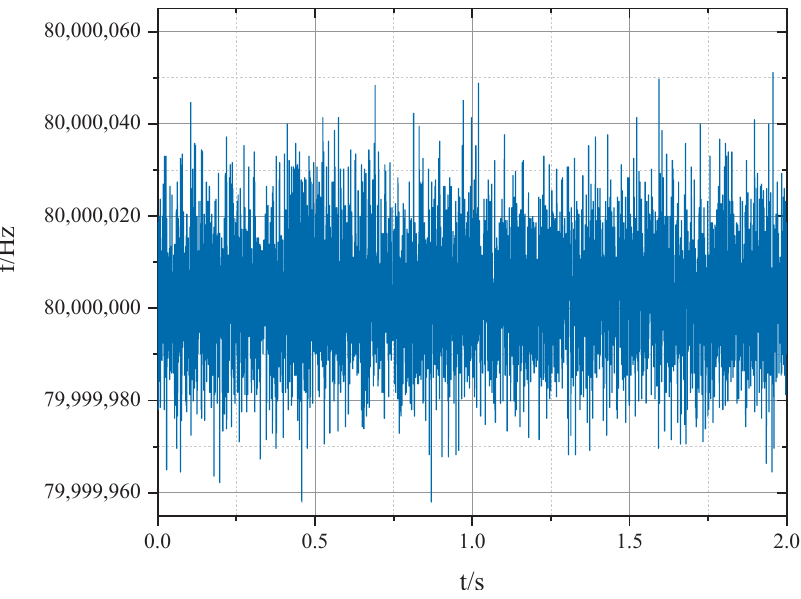
Figure 15. Detailed frequency measurement results of the proposed method. Table 3. Frequency Measurement Accuracy and Stability of the System at 2 kHz Sampling